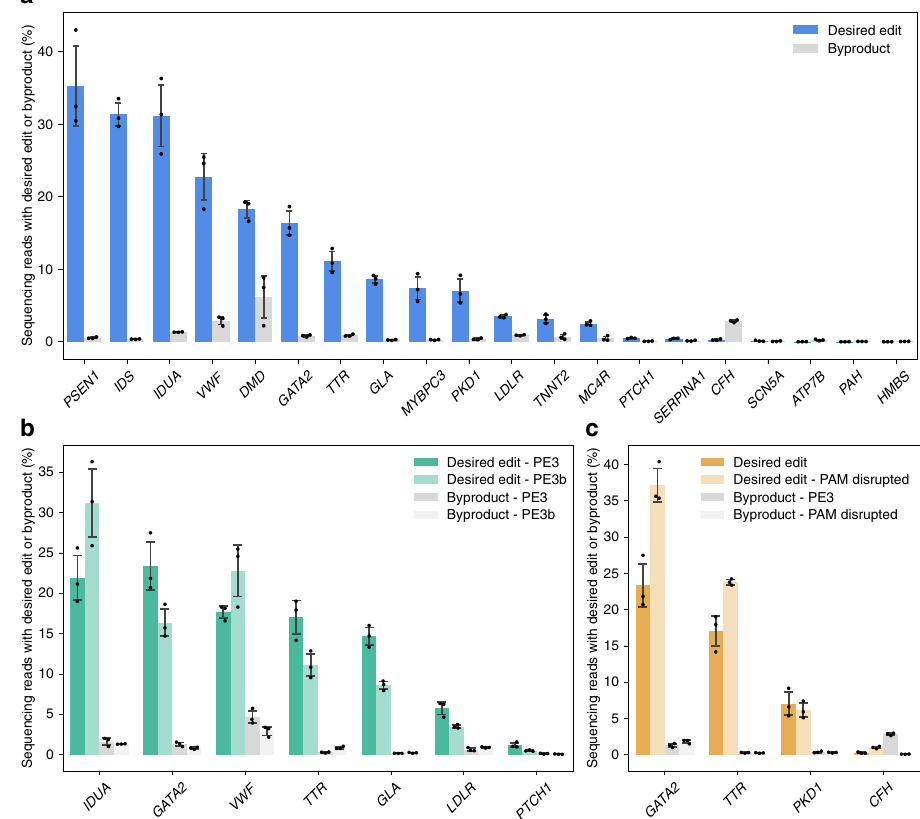
Fig. 3 Installation of human pathogenic variants in HEK293T cells with PrimeDesign. a Overview of prime editing ef fi ciencies for the installation of 20 human pathogenic variants in HEK293T cells, using PrimeDesign recommendations. Desired edit refers to sequencing reads containing only the edit of interest, while byproduct refers to sequencing reads containing any mutation(s) outside of only the edit of interest (i.e. indels, desired edit and indels). b Comparison between PE3 and PE3b editing strategies. c Assessing the effects of PAM-disrupting silent mutations on prime editing ef fi ciencies. Mean ± s.d. of n = 3 independent biological replicates. Some of the data shown in a are also represented in b and c . See Supplementary Data 2 for details. Source Data is available in the Source Data fi